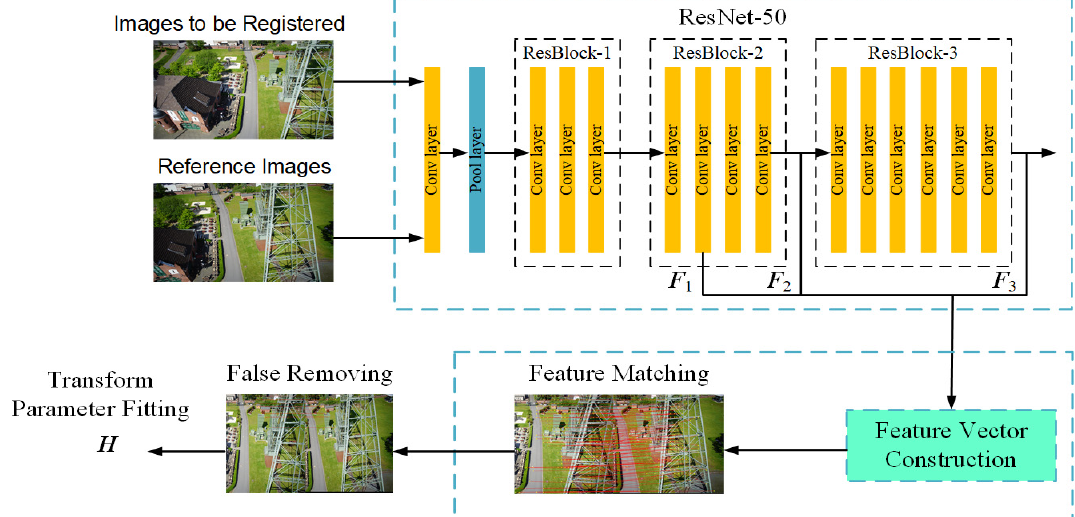
Figure 1. The registration pipeline of our proposed method based on deep residual features. Firstly, three feature map F 1 , F 2 , and F 3 corresponding to an 8 × 8 pixel region in UAV images are extracted from ResNet-50. Then they are feature integrated by Kronecker product to construct feature vectors. Finally, the PROSAC algorithm is performed to remove false matches and yield a homography matrix, H , for registration transform.